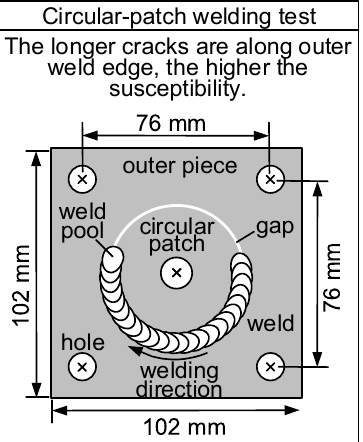
Figure 2. Circular-patch test for liquation cracking. Outer piece is bolted down tightly to thick base plate (not shown) to keep weld from shrinking, thus inducing transverse tension and liquation cracking along outer weld edge.